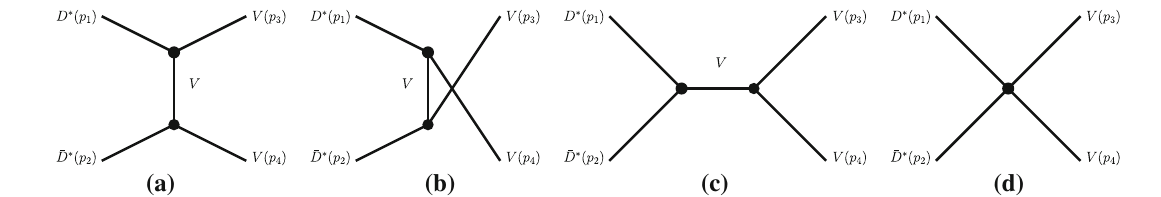
Fig. 1 The sketch diagrams for D ∗ ¯ D ∗ → V V . Diagrams a – d correspond to t -channel, u -channel, s -channel vector meson exchanged interactions, and contact interaction,